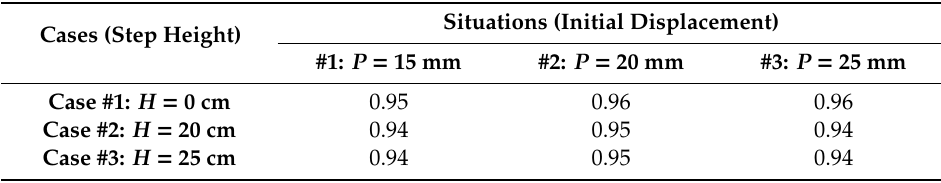
Table 4. Correlation coe ffi cients between di ff erent cases and the reference.